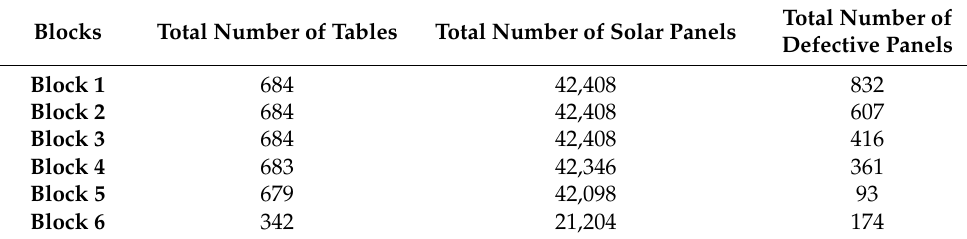
Table 2. Defects in each